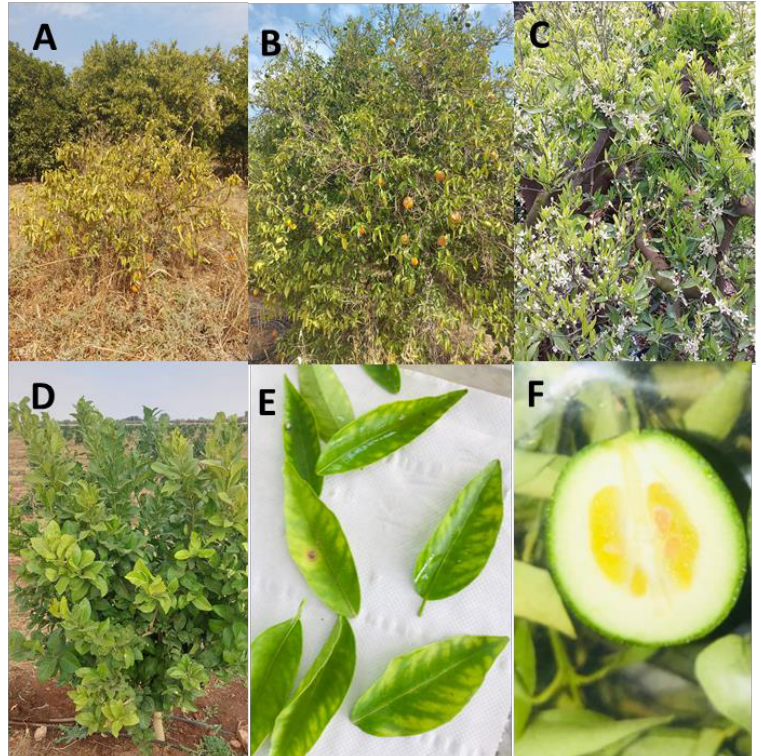
Figure 2. Field symptoms of citrus stubborn disease observed in sweet orange trees ( Citrus sinensis ) in the Tadla region in the growing season of 2021. ( A , B ) Stunted Navel sweet orange trees, ( C ) tree with off-season flowering, ( D ) infected young plant of sweet orange on sour orange rootstock, ( E ) leaf chlorosis, ( F ) Navel sweet orange fruit showing a gland shape.